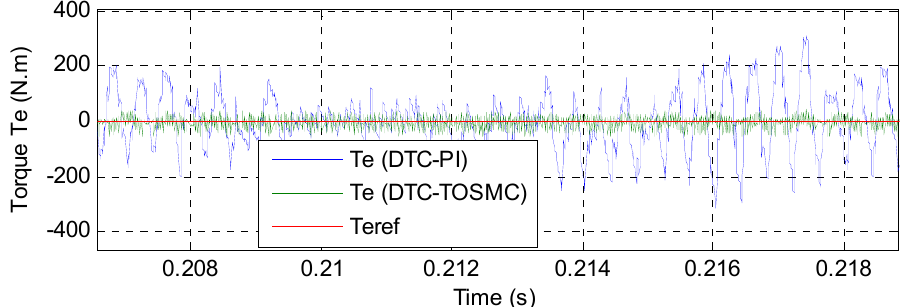
Figure 10. Stator current.